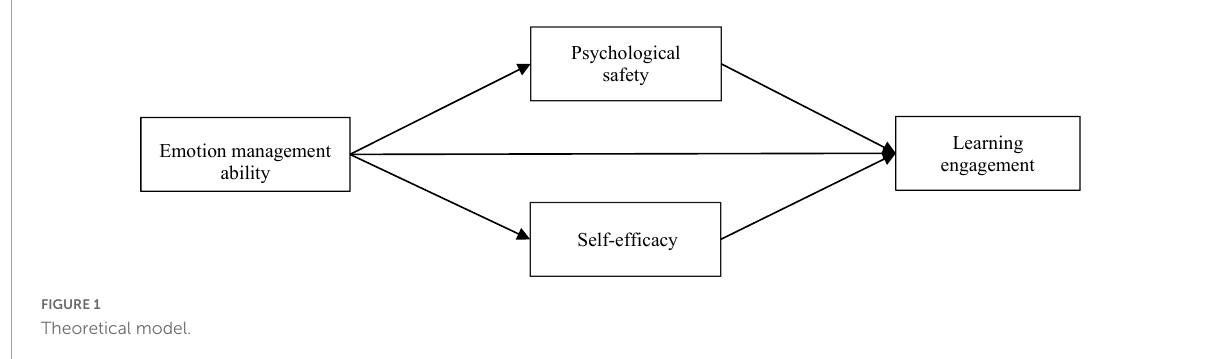
FIGURE1 Theoretical